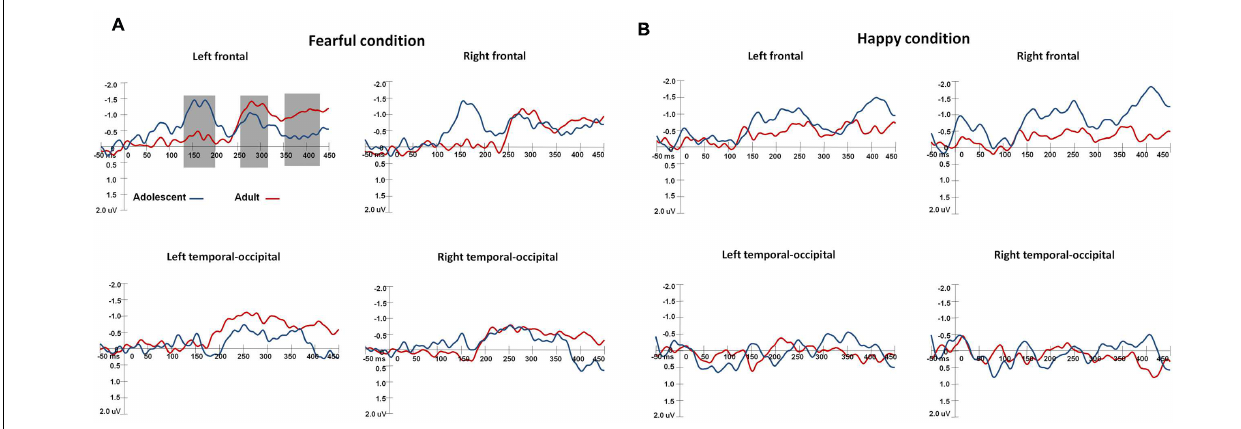
Frontiers in Psychology |